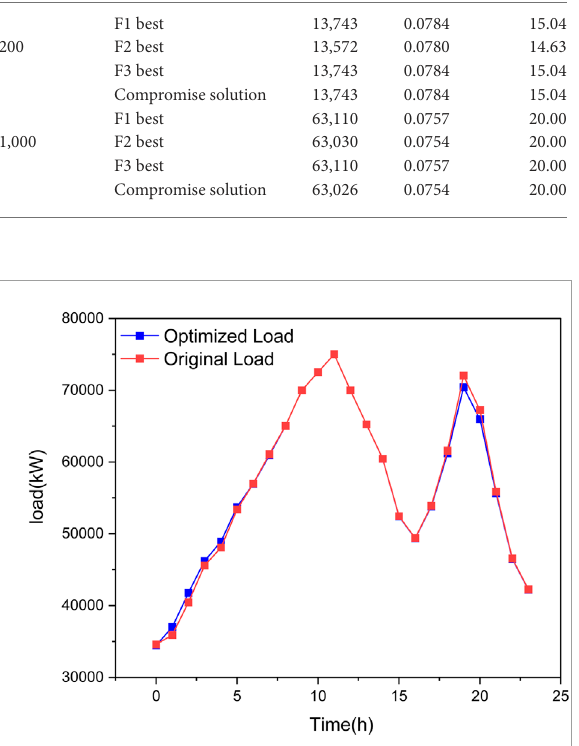
FIGURE 8 Microgrid load curve before and after optimization when there are 200 electric